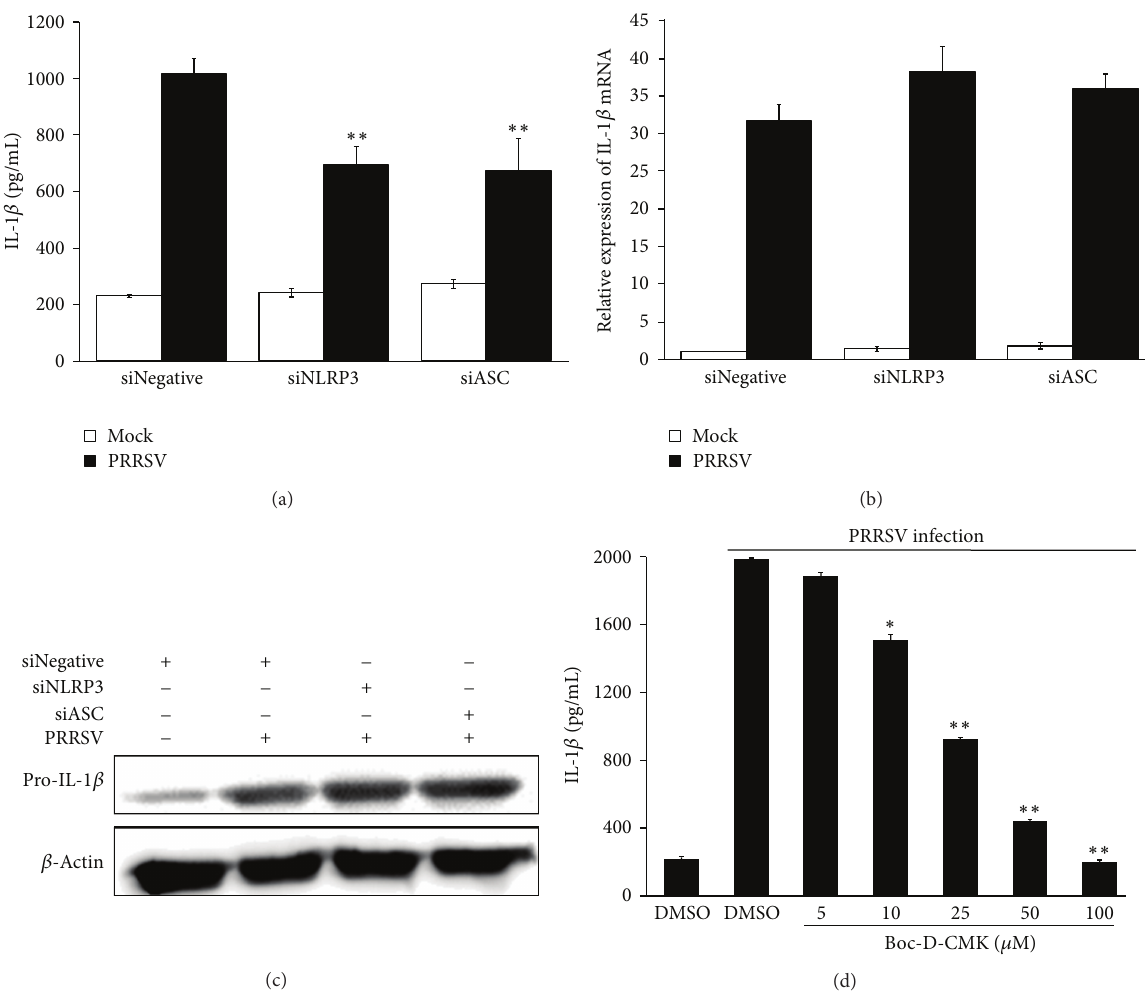
Figure 7: PRRSV-induced IL-1 𝛽 secretion requires NLRP3 inflammasome. (a–c) PAMs were transfected with 80 nM of psiNegative, psiNLRP3,orpsiASC,respectively.At24 hposttransfection,cellsweremockinfectedorinfectedwithPRRSVataMOIof0.1.Thesupernatants and cells were harvested separately 36 h later and analyzed by IL-1 𝛽 ELISA (a) and real-time RT-PCR (b), respectively. For Western blotting to detect pro-IL-1 𝛽 , cells were harvested at 24 h postinfection by using polyclonal antibody against pro-IL-1 𝛽 (c). (d) PAMs were mock infected or infected with PRRSV at a MOI of 0.1, followed by treatment with caspase 1 inhibitor (5, 10, 25, 50, and 100 𝜇 M) or DMSO vehicle in the absence of serum, for 36 h. The supernatants were then harvested and analyzed by IL-1 𝛽 -specific ELISA. ∗ 𝑃 < 0.05 and ∗∗ 𝑃 < 0.01 compared with DMSO-treated cells plus PRRSV